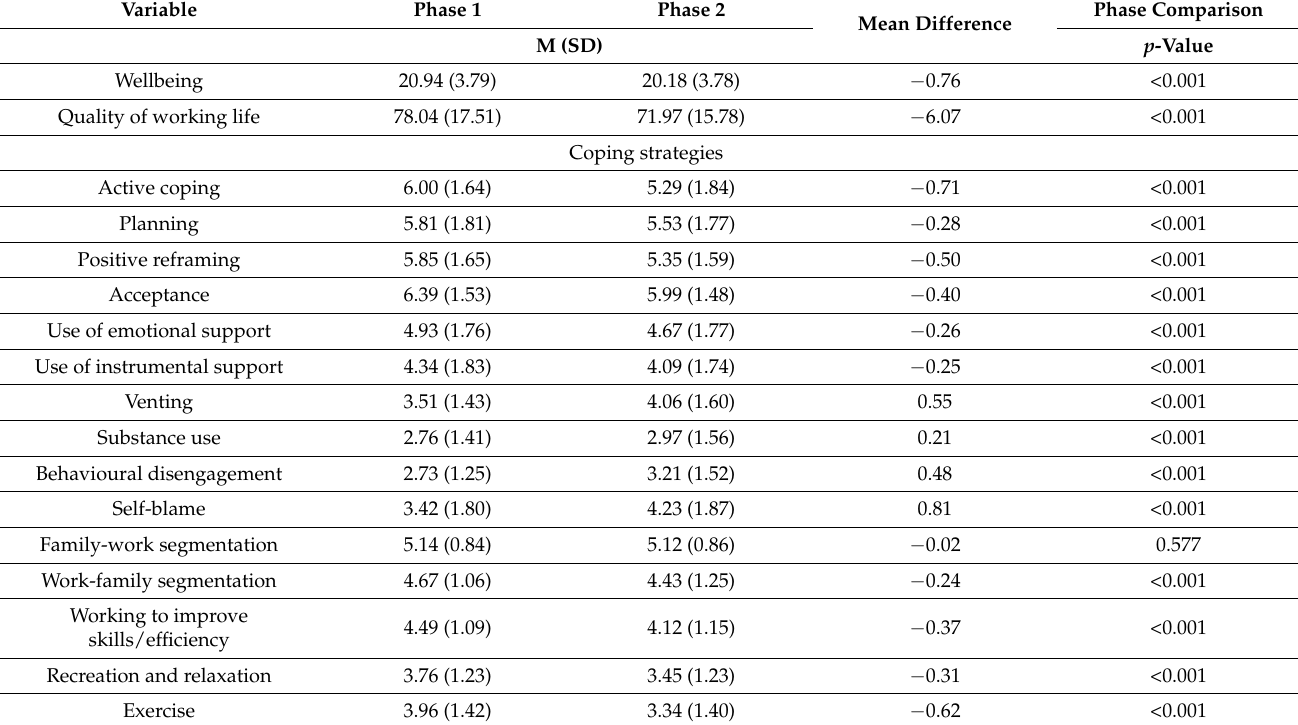
Table 2. Means and standard deviations (in brackets) for Wellbeing, Work-Related Quality of Life (WRQoL), and Coping strategies across study